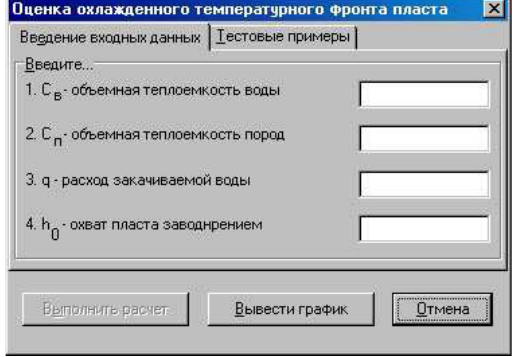
Figure 9: Changing the cooled thermal front of the formation